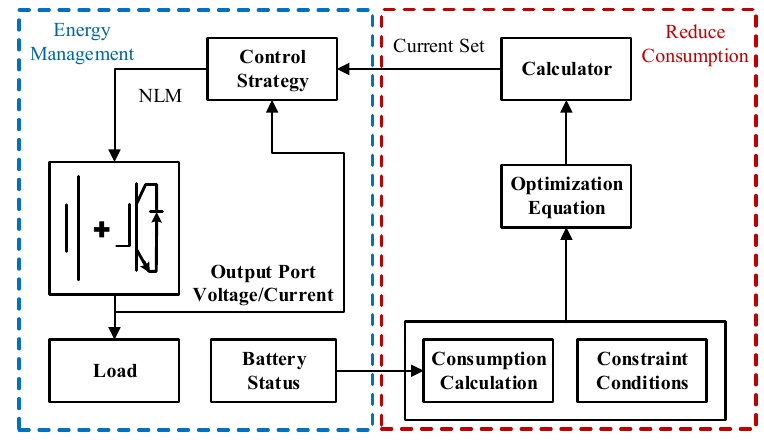
Figure 10. Multistage current charging method for MMC-BESS.